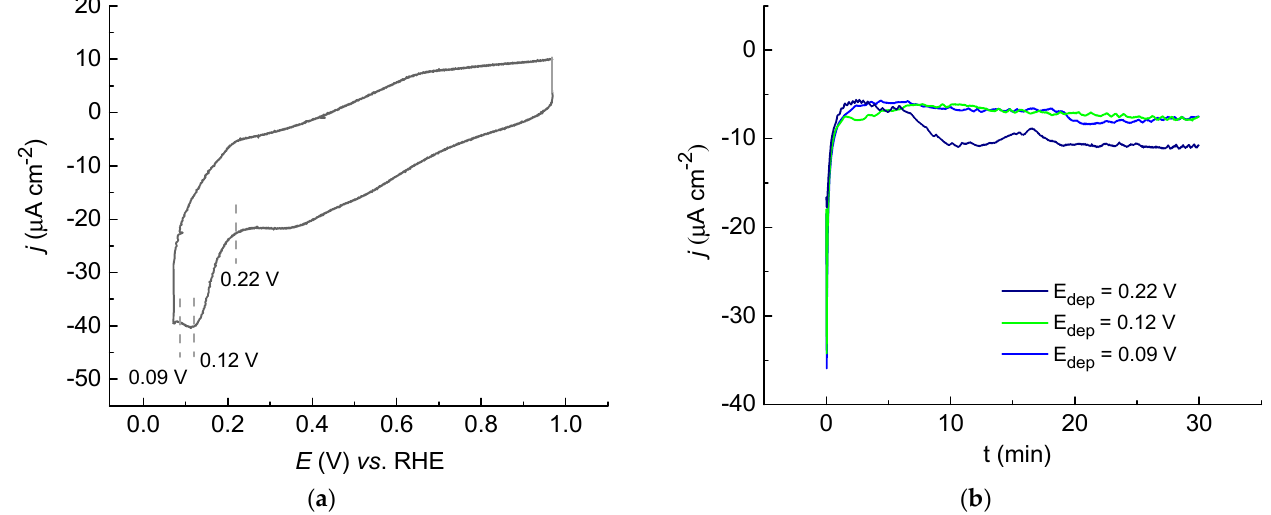
Figure 1. The electrochemical deposition of platinum on the GC substrate from 10 − 4 M H 2 PtCl 6 + 0.05 M H 2 SO 4 solution: ( a ) CV of bare GC electrode recorded at a scan rate of 50 mV s − 1 ; ( b ) CA curves recorded at different deposition potentials.